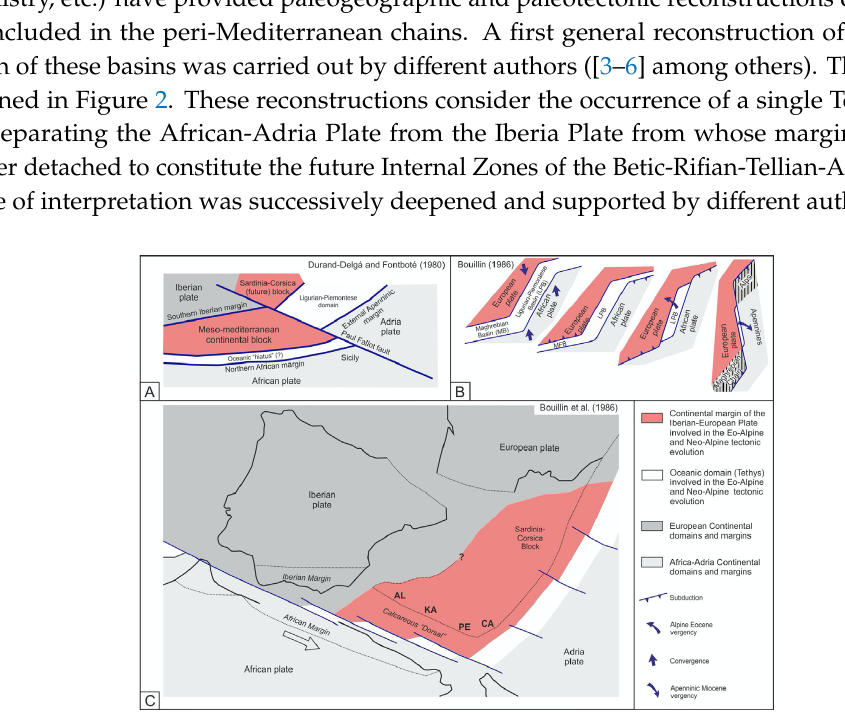
Figure 2 Figure 2. Reproduction of some paleogeographic and paleotectonic evolutionary models of the central-western peri-Mediterranean region (redrawn and simplified). ( A ) Jurassic evolution (After [4]); ( B ) From Cretaceous to Miocene (after [5]; ( C ) From Cretaceous to Miocene (after [6–9]): AL, Alboran; KA, Kabilides; PE, Peloritani; CA, Calabria. The reconstructions show two opposite subductions occurring in the same oceanic